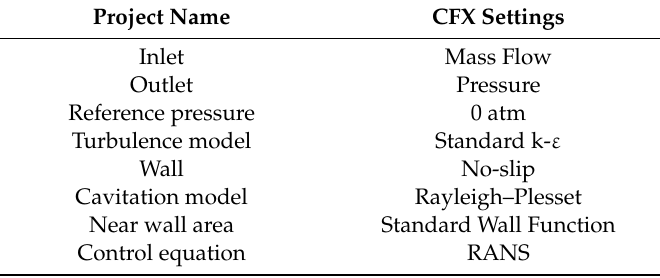
Table 2. Settings of boundary condition.